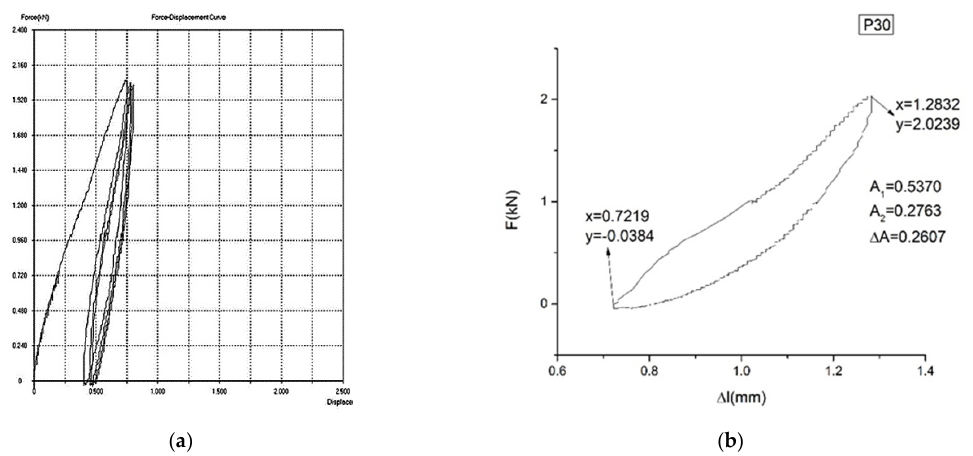
Figure 8. Force–displacement diagram for sample P30: ( a ) F = f( Δ l) for 5 cycles of loading–unloading. ( b ) F = f( Δ l) for the last cycle of loading–unloading. The yield of sample P30 is η = 48.54%.